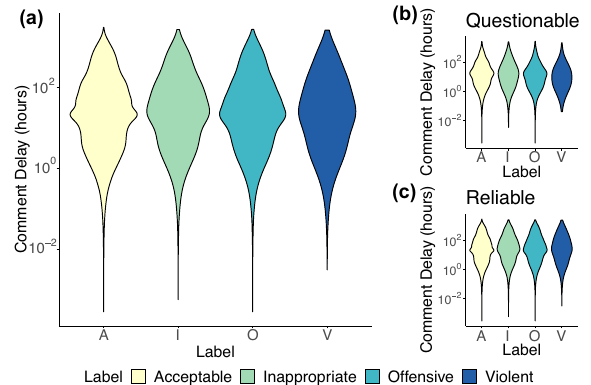
Figure 4. Distribution of comment delays in the whole dataset ( a ) and for questionable ( b ) and reliable ( c ) YouTube channels. The capital letters on the x-axis represent the different types of comments: acceptable (A); inappropriate (I); offensive (O); violent